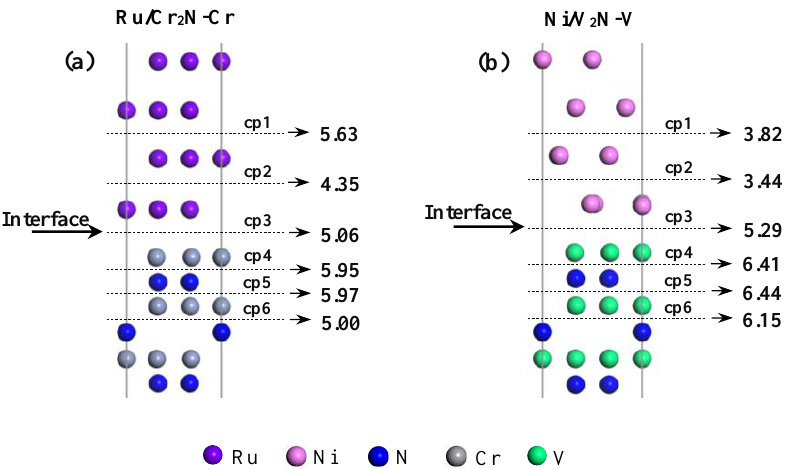
Figure 11. Different cleavage planes (cp1~cp6) for the ( a ) Ru(0001)/Cr 2 N(0001)-Cr and ( b ) Ni(111)/V 2 N(0001)-V interface models. Here, the values of W ad (unit: J/m 2 ) obtained for the models along cp1~p6 cleavage planes are also labeled.